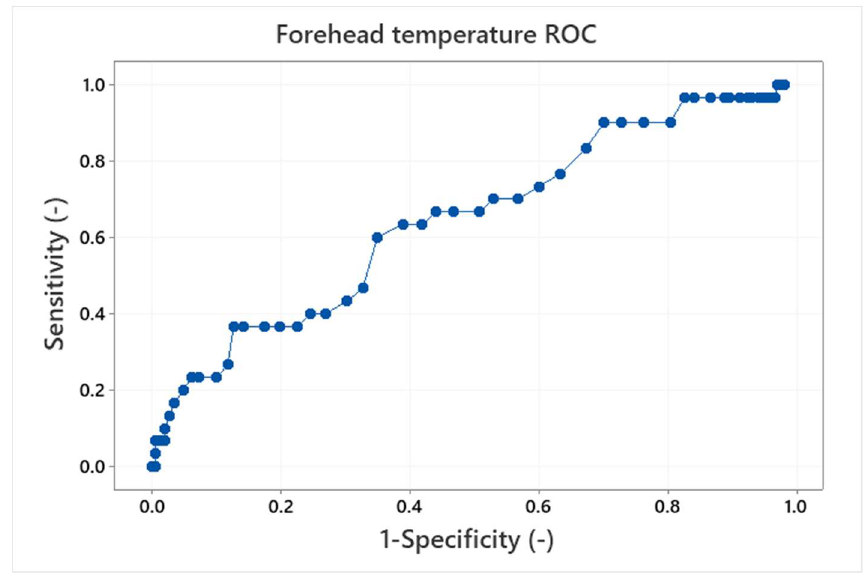
Figure 17. Receiver operation curve (ROC) for the forehead temperature and the APT threshold 36.5 °C. The area under curve is 0.64. 36.5 ◦ C. The area under curve is